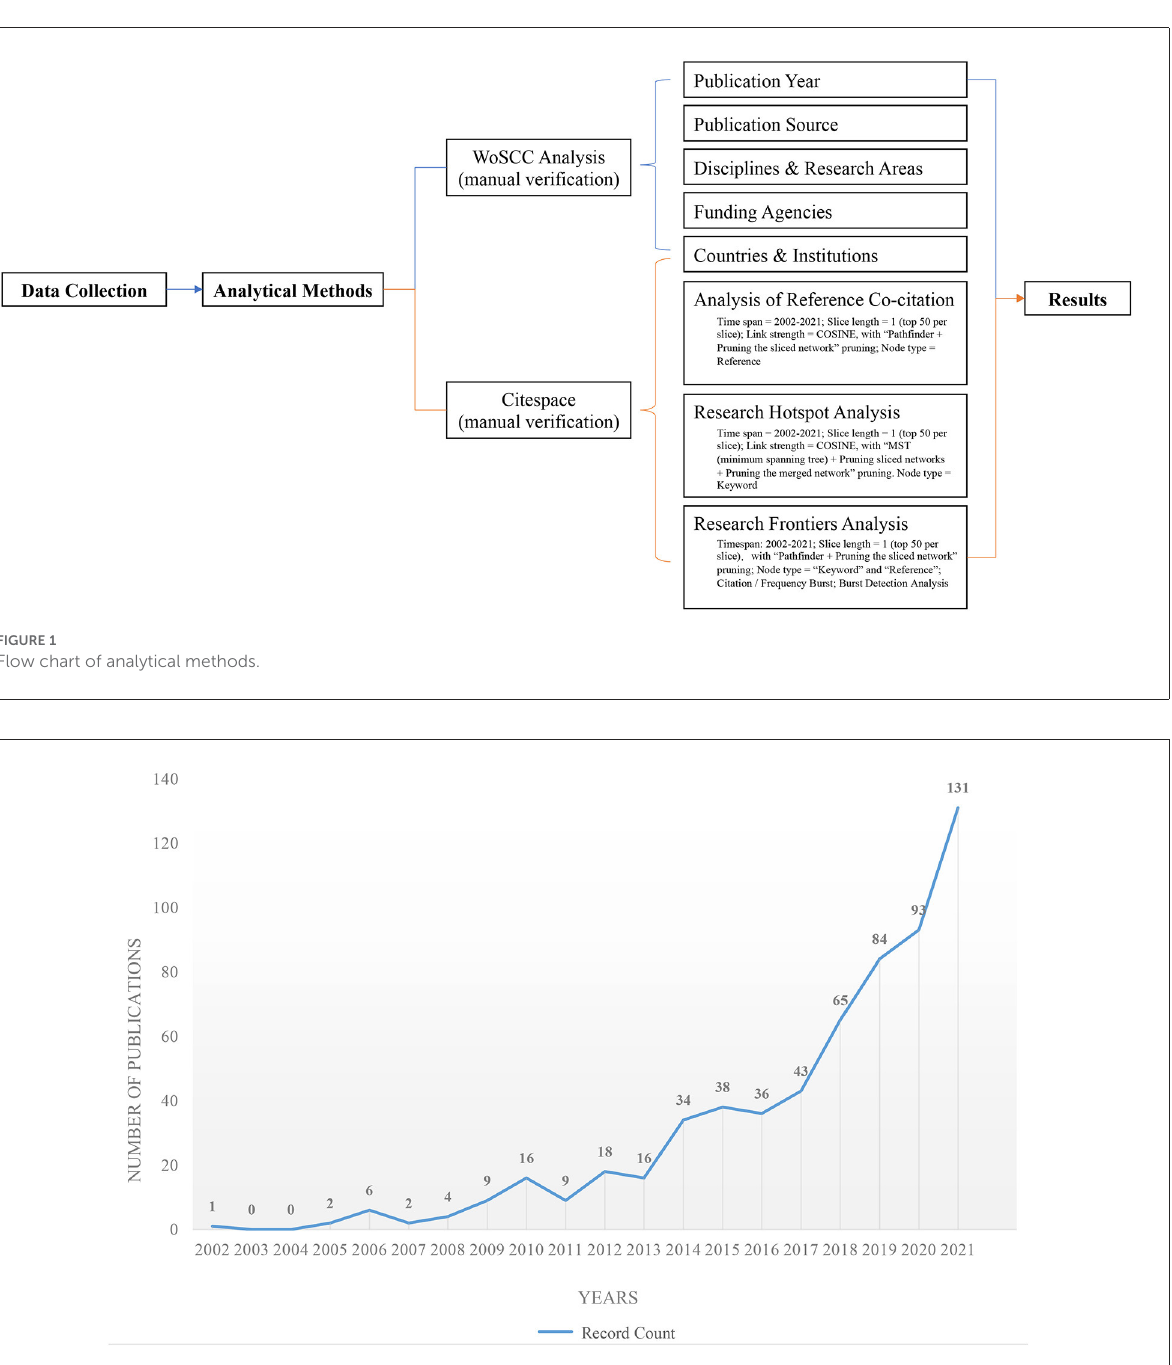
Studies (82), Green Sustainable Science Technology (43), and Geography (40), respectively. Moreover, the research field involves 73 research areas, of which, the area of Environmental Sciences Ecology accounts for the highest occupation (247